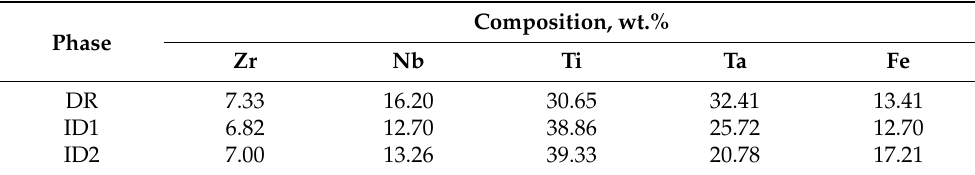
Figure 18. SEM image of the FeMnNb 0.5 TiZr 0.5 alloy sample with the selected points for EDS analysis. Table 7. EDS composition for the FeTa 0.5 Nb 0.5 TiZr 0.5 alloy, in